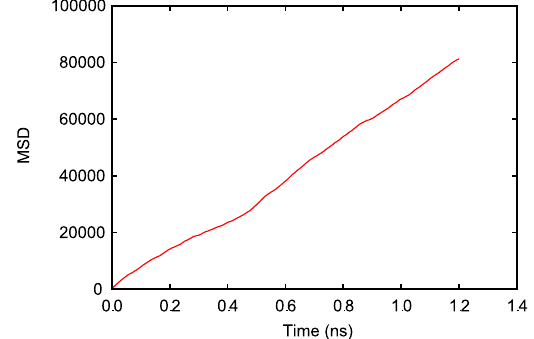
Figure 5. Time evolution of MSD 〈 Δ n * 2 ( t ) 〉 at T = 1,155 K (Cu 50 Zr 50 ).